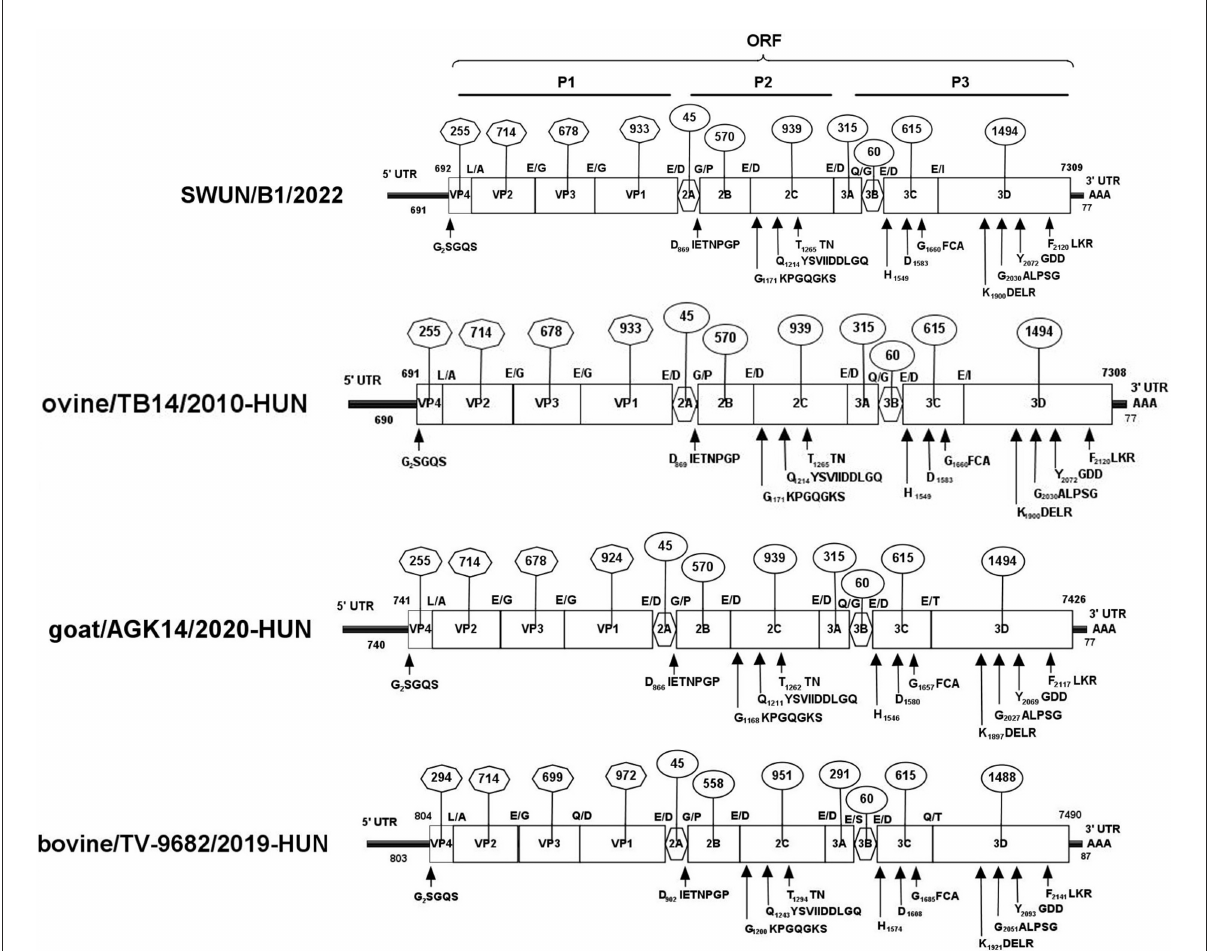
FIGURE3 Genomic organization of the “Bopivirus B” strain SWUN/B1/2022 identified in this study and the other reference bopivirus strains in the GenBank database. Circled numbers indicate the length of each gene, and plain numbers indicate the location of the genome. The positions and sequences of conserved amino acid motifs of 2C helicase, 3C protease, and 3D RdRp (RNA-dependent RNA polymerase) are shown under each map of the viruses.